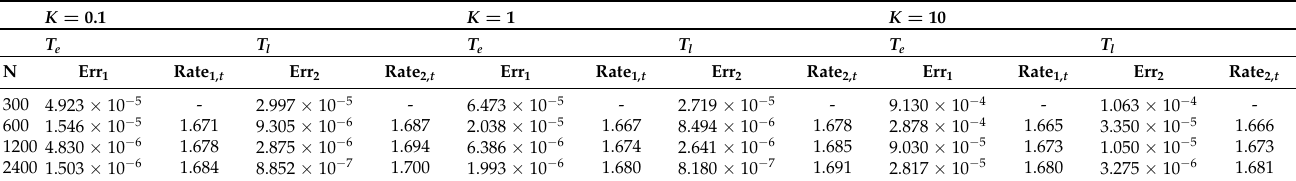
Table 1. Temporal convergence rate when M = 500 and ( α , β ) = ( 0.3,0.2 ) for Example 1.